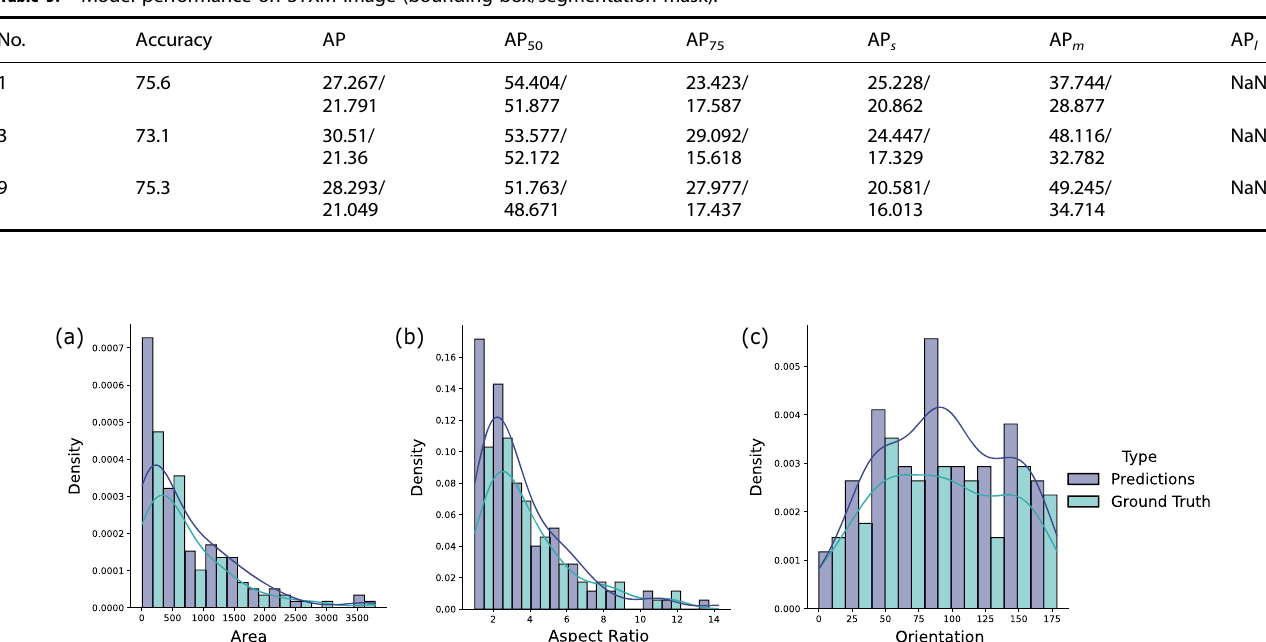
Table 3. Model performance on STXM image (bounding box/segmentation